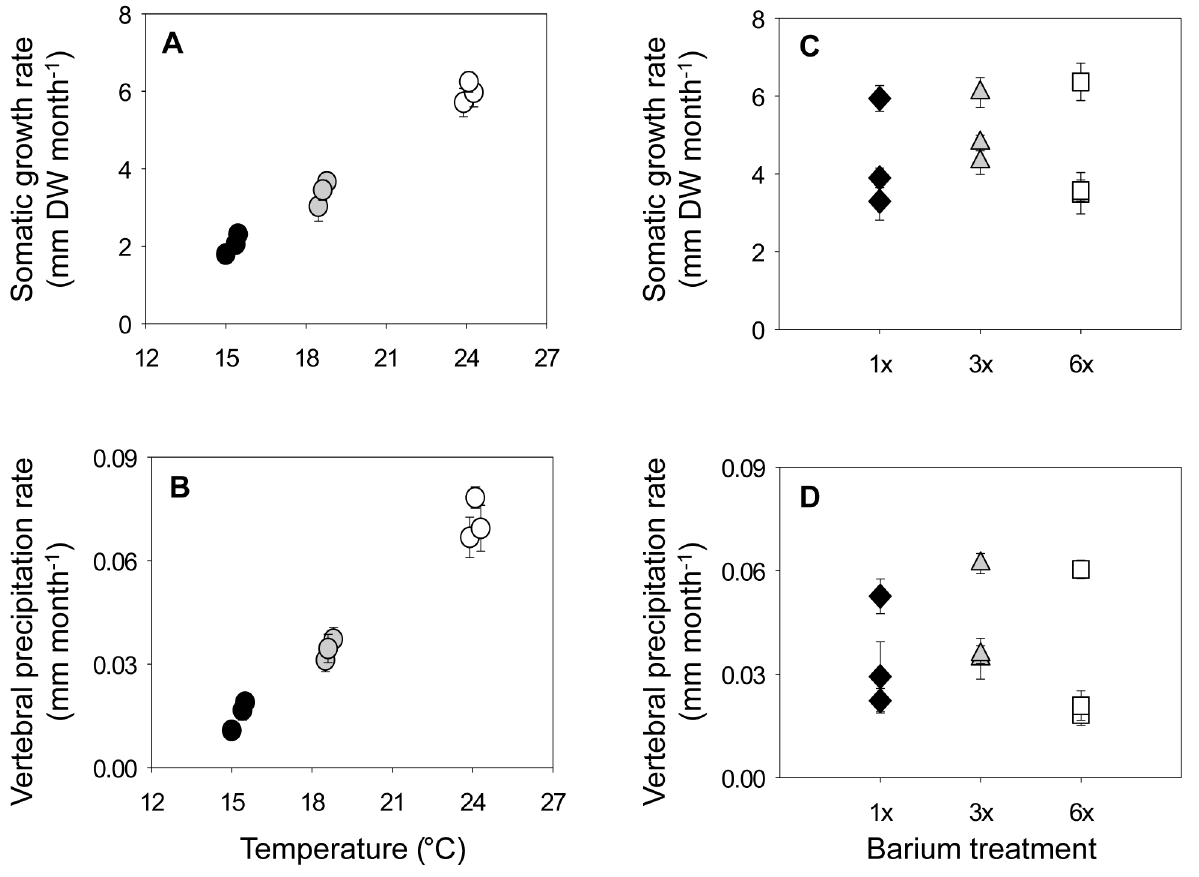
Mean somatic growth and vertebral precipitation rates during temperature and barium manipulation experiments. Mean (A, C) somatic growth and (B, D) vertebral precipitation rates by tank, treatment, and experiment (± standard error). (A, B) Black circles represent 15°C treatments, grey circles 18°C treatments, and open circles 24°C treatments. (C, D) Black diamonds represent 1x, grey triangles 3x, and unfilled squares 6x that of average local barium values. Temperatures were equivalent among treatments (19°C) during the barium manipulation